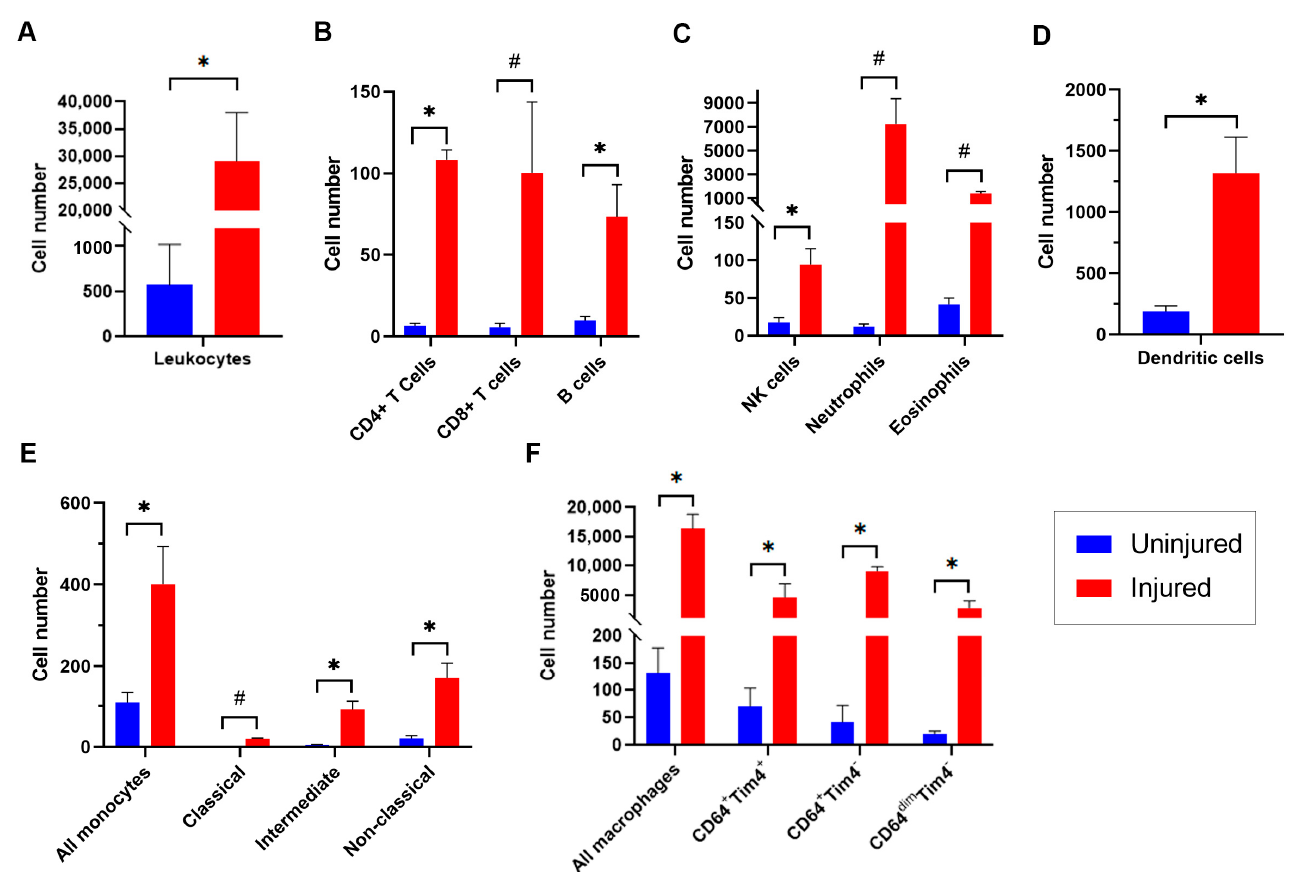
Figure 3. Comparison of leukocytes and leukocyte sub-populations identified using high-parameter flow cytometry in uninjured arteries and in femoral artery samples 3 days after injury. Comparisons are in numbers of live leukocytes ( A ), B and T lymphocytes ( B ), natural killer (NK) cells, neutrophils, and eosinophils ( C ), dendritic cells ( D ), monocytes and monocyte subpopulations ( E ), and macrophages and macrophage subpopulations ( F ). Each bar represents the mean cell number ± SEM of at least 3 samples, each comprising 2 arterial segments. p values calculated using Stu- dent’s t -test. CM, classical monocytes. IM, intermediate monocytes. NC, non-classical monocytes. * p = 0.007, # p =